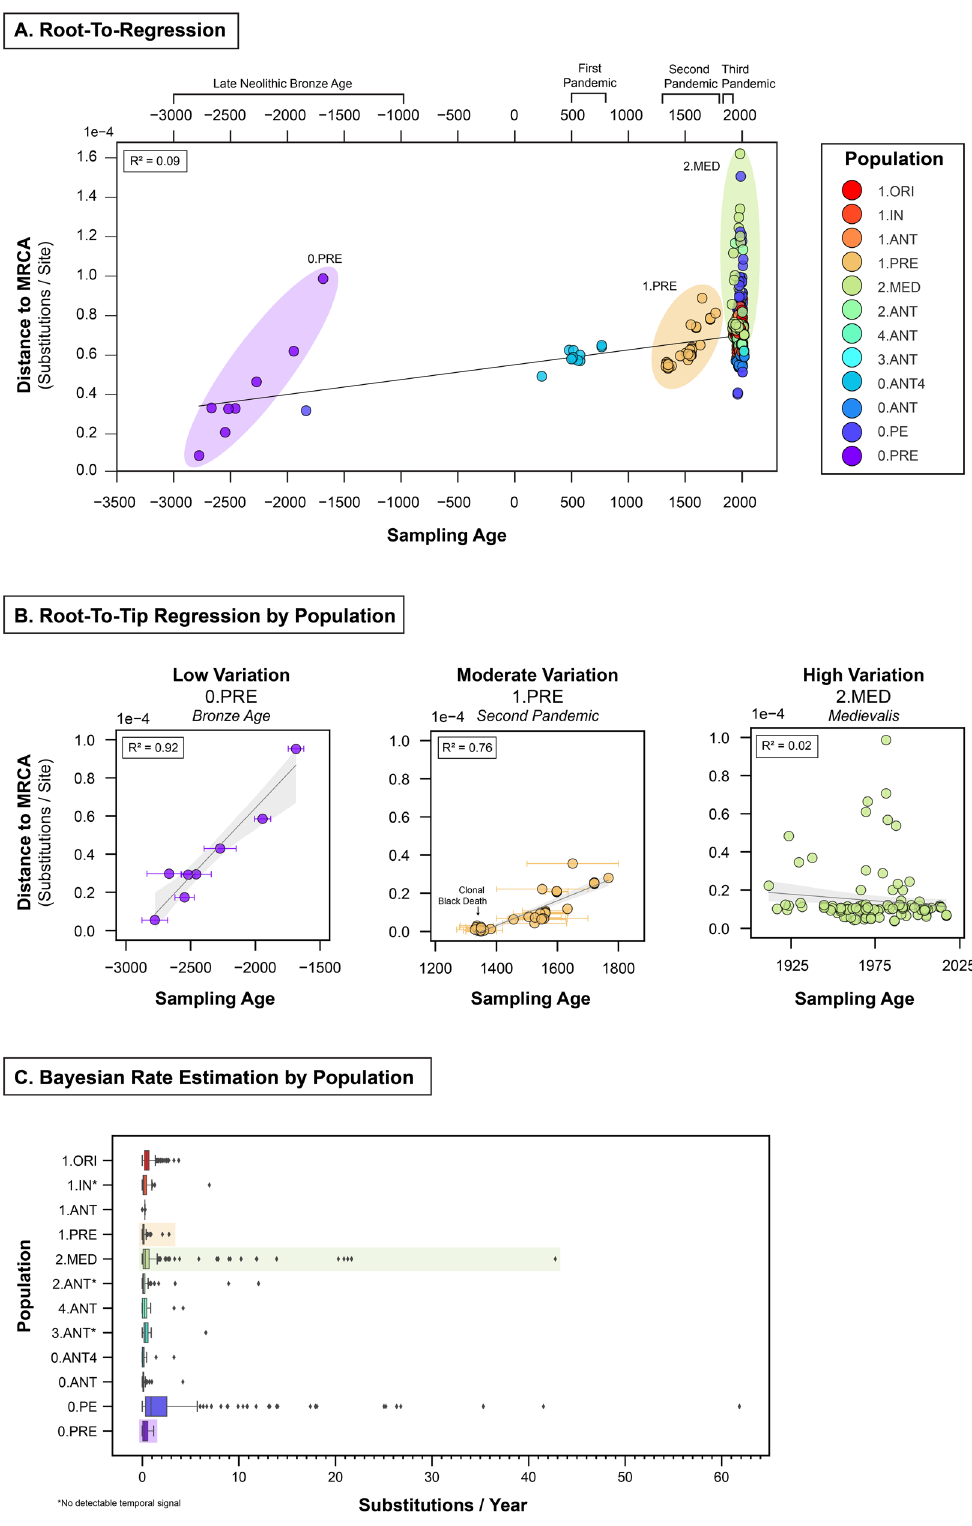
Fig. 2 Substitution rate variation in Y. pestis . A A root-to-tip regression on mean sampling age using all genomes from the maximum likelihood phylogeny. B A root-to-tip regression on mean sampling age by population. The distance to the population MRCA was calculated using subtrees extracted from the maximum likelihood phylogeny. C Bayesian substitution rates within and between populations. For each branch in the maximum clade credibility (MCC) trees, we extracted the estimated substitution rate (subs/site/year) and converted this to subs/year based on an alignment of 4,229,098 genomic sites.